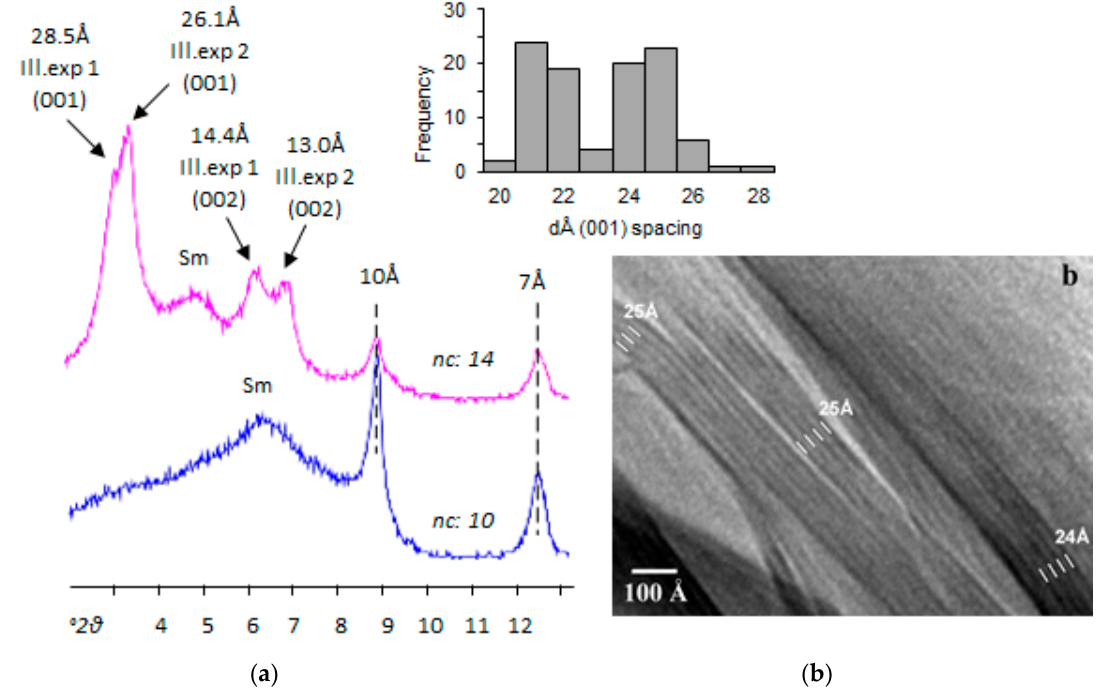
Figure 3. ( a ) XRD profiles of <2 µm representative of the R0 diagenesis stage, treated with nc:10 and nc:14 alkylammonium ions. ( b ) HRTEM image of micaceous packets with coherent sequences of interlayers expanded with 14-alkylammonium with spacings of 24–25 Å; long chain alkylammonium treatment in HRTEM shows two expandable micaceous phase populations (see histogram).